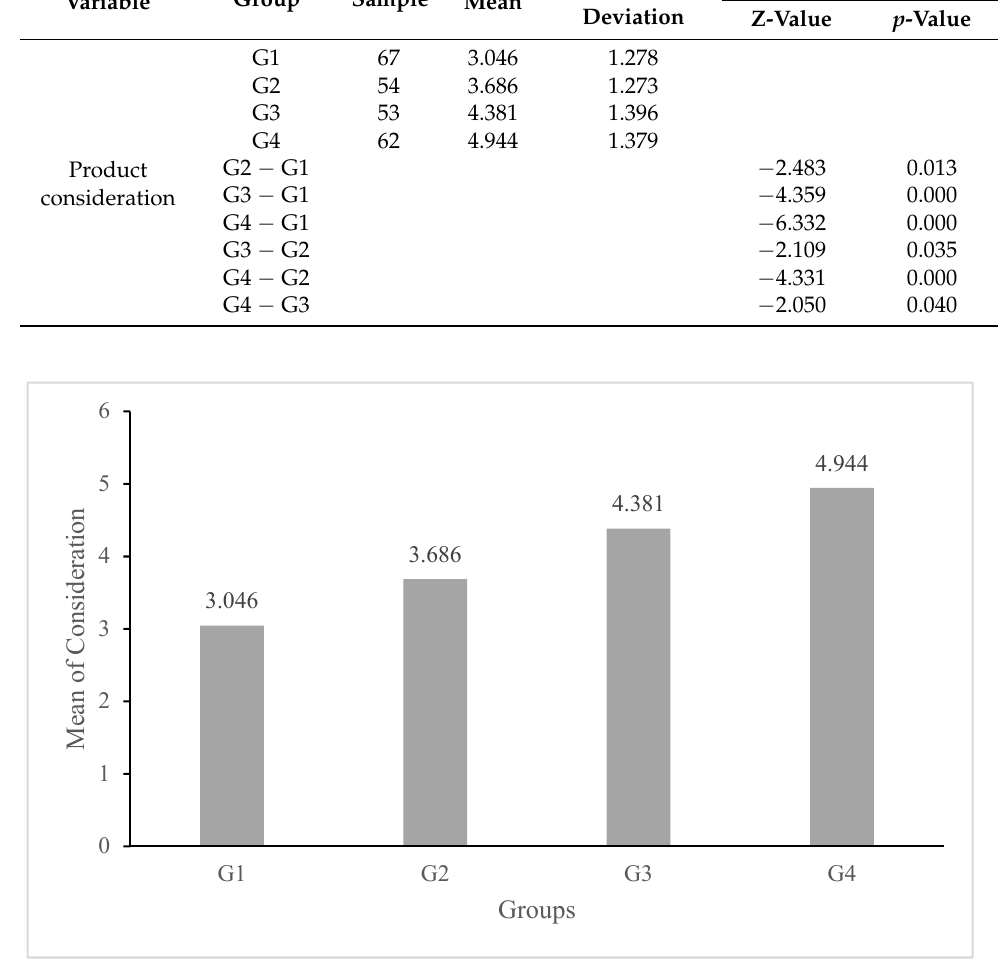
Figure 3. Mean value of product consideration among different groups.